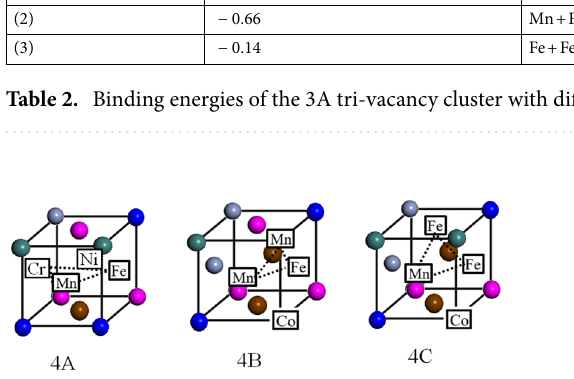
Figure 6. Schematic diagram of tetra-vacancy cluster composed of a single vacancy and a tri-vacancy with different atomic vacancy formation sequences. The three elements enclosed within squares and connected by dotted lines in the figures each indicate the configuration of the tri-vacancy cluster formed first, and the other element (also enclosed within a square) represents the fourth vacancy of the tetra-vacancy cluster.